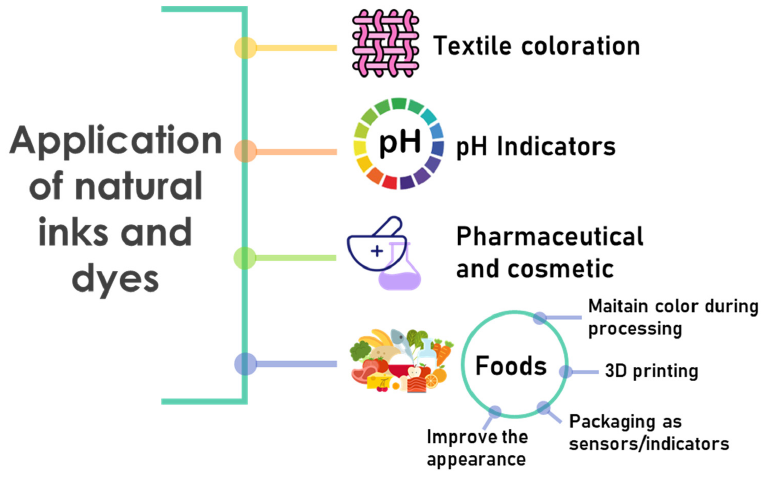
Figure 5. Areas of application of natural inks and dyes. Natural colorants can be classified according to their hue (red, yellow, brown, blue, purple, black, green, and orange), their origin (vegetal, animal, bacterial, fungal, etc.) or their chemical structure as follows: flavonoid derivatives (anthocyanins), isoprenoid de-